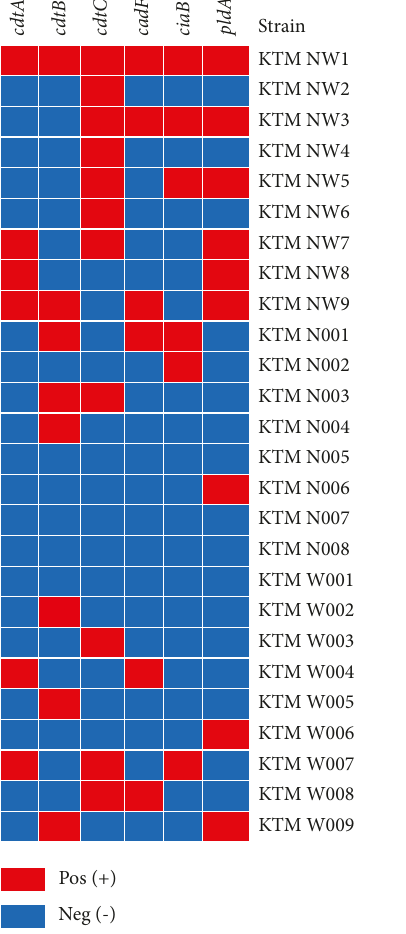
Figure 1: Distribution of the six virulence genes in C. jejuni isolates. Red colour represents the presence, and blue colour represents the absence of the virulence